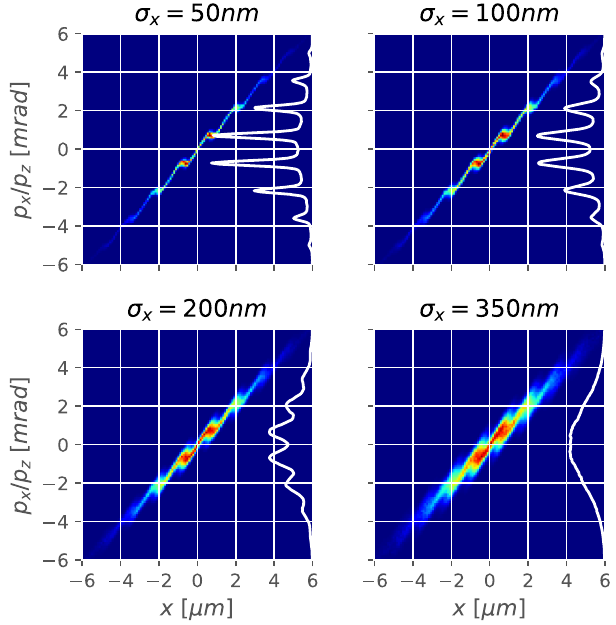
FIG. 6. Momentum space of electron beam ( γ e ¼ 100 , σ ¼ 2 mrad, σ ¼ 2 μ m) after interaction with laser ( I x 0 z 3 . 5 × 10 16 W = cm 2 ) for different electron source sizes σ curve: transverse momentum space integrated along x (measured signal on detector).